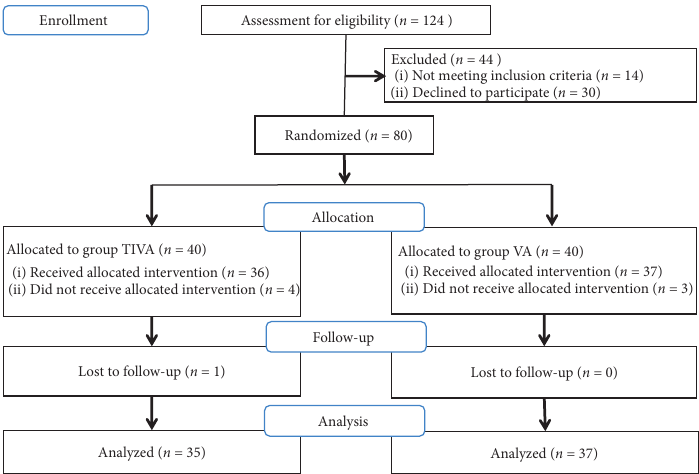
Figure 1: CONSORT diagram of participant flow. Table 1: Demographics of the study population and basal characteristics.